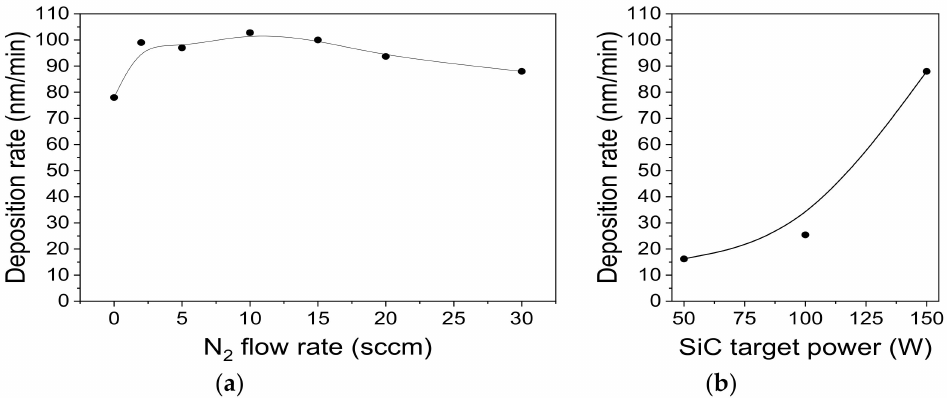
Figure 2. ( a ) Deposition rate of films versus nitrogen flow rate (series A); ( b ) Film growth rate as a function SiC target power (series